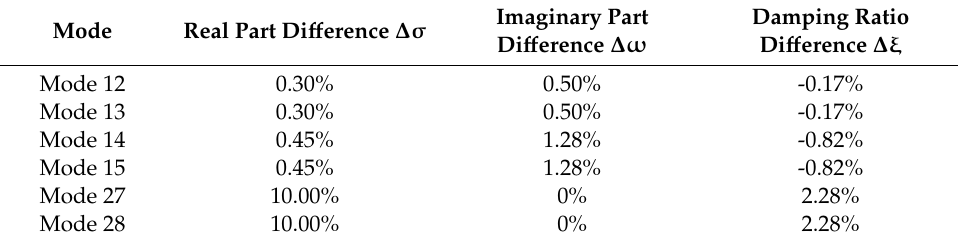
Table 6. Oscillatory modes, operating point 1, di ff erence SVC connected / disconnected.